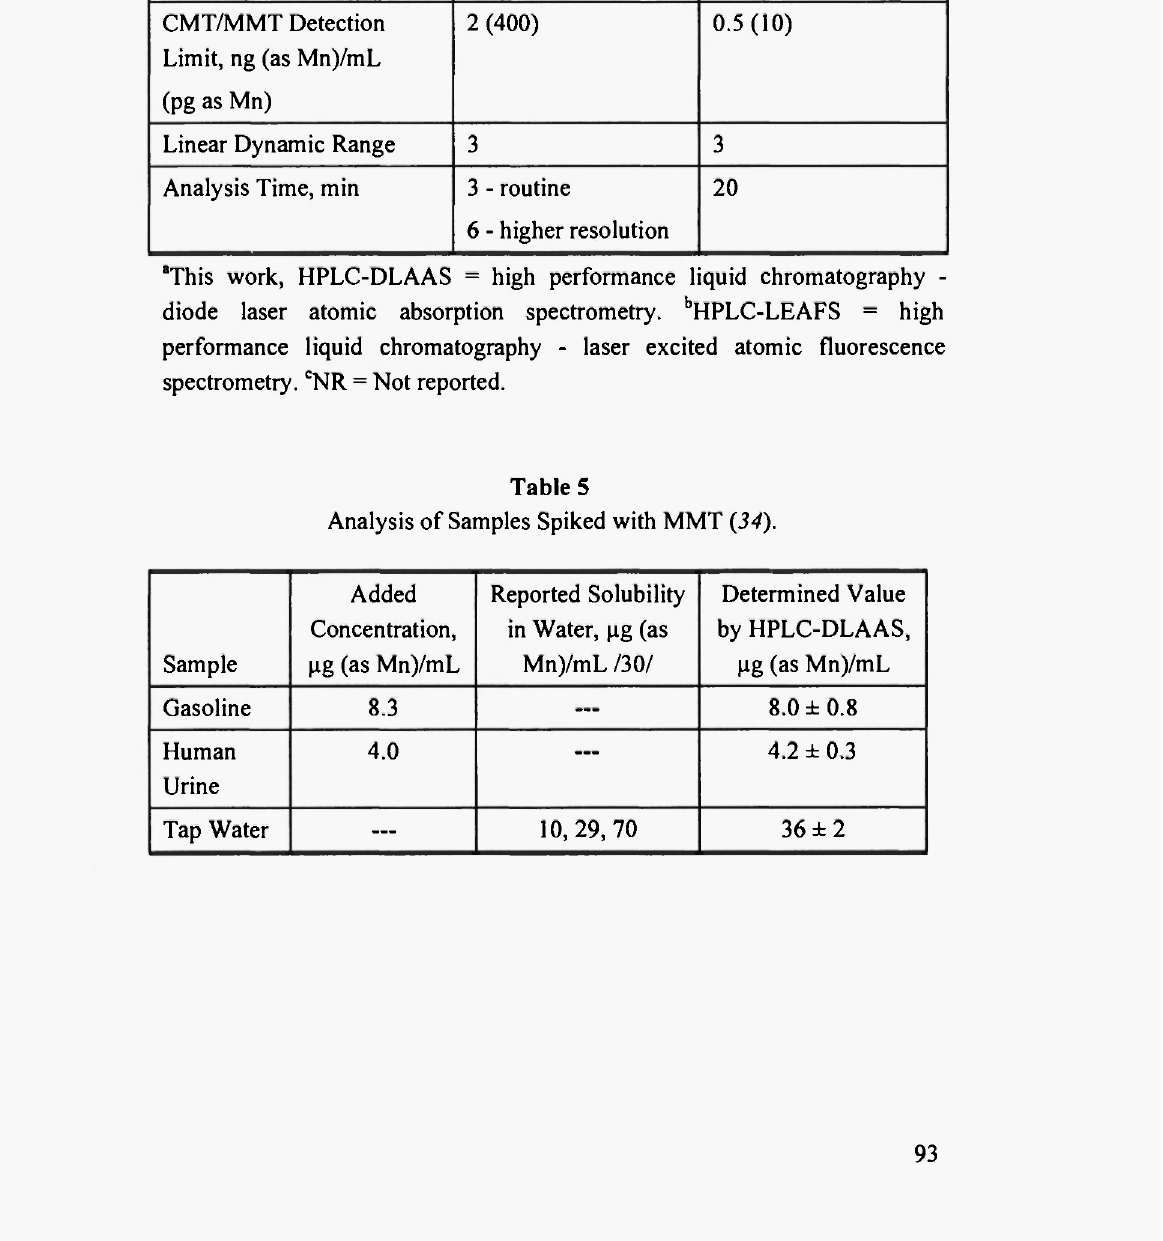
Comparison of Analytical Figures of Merit of HPLC-DLAAS to HPLC- LEAFS for Determination of Inorganic Manganese, CMT, and MMT /34/. Figure of Merit